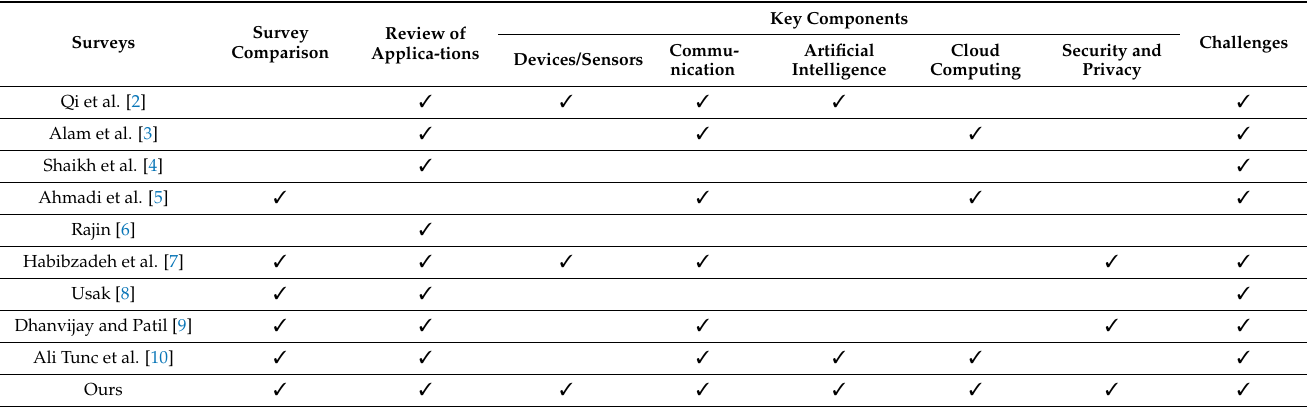
Table 1. Literature survey comparison. The checkmark ( (cid:51) ) denotes the availability of the mentioned content in the survey.